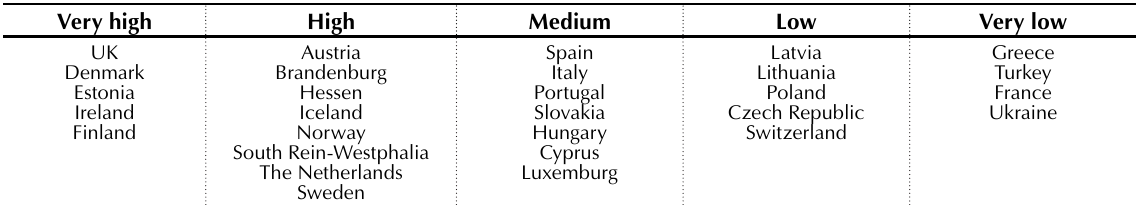
Table 3. Structure of cluster groups by the level of overall autonomy Very high